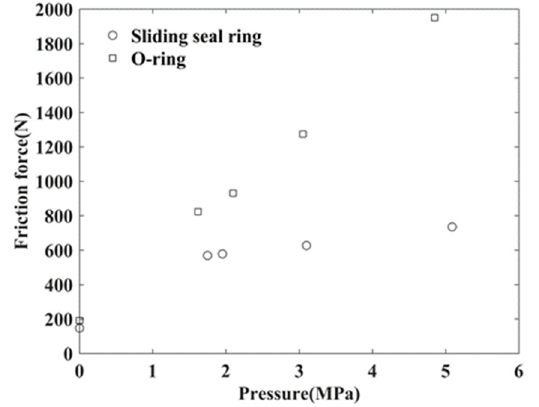
Figure 5. Test results of single piston frictional force with respect to hydraulic pressure.